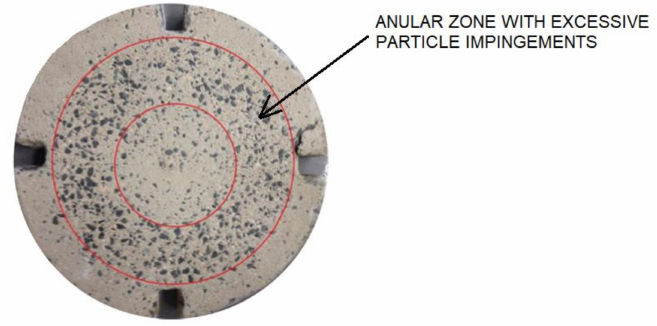
Figure 5. Surface of specimen after 24 h (reprinted from ref.